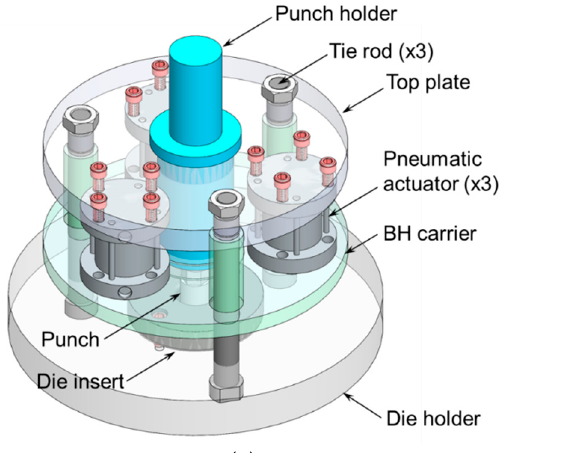
Table 1. Critical cup heights and wave numbers for cups drawn under different blankholding forces.